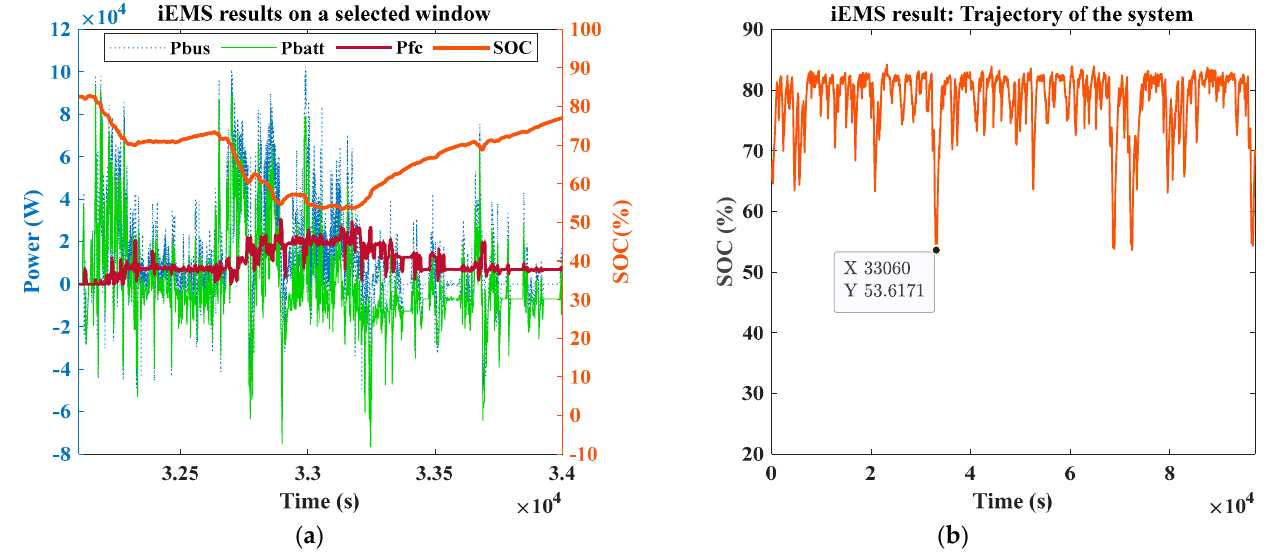
Figure 13. Online PMP costate results compared with the optimal PMP on the selected window.